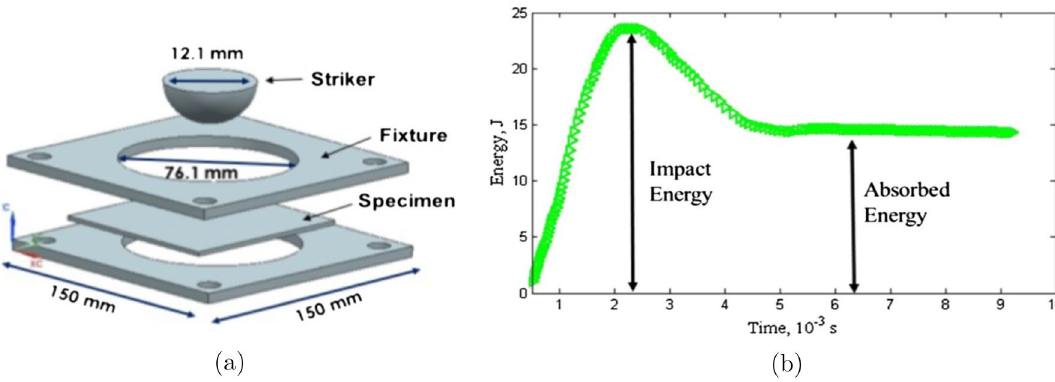
Figure 4. ( a ) Schematic of the impact fixture. ( b ) Typical energy-time response to dynamic impact loading.